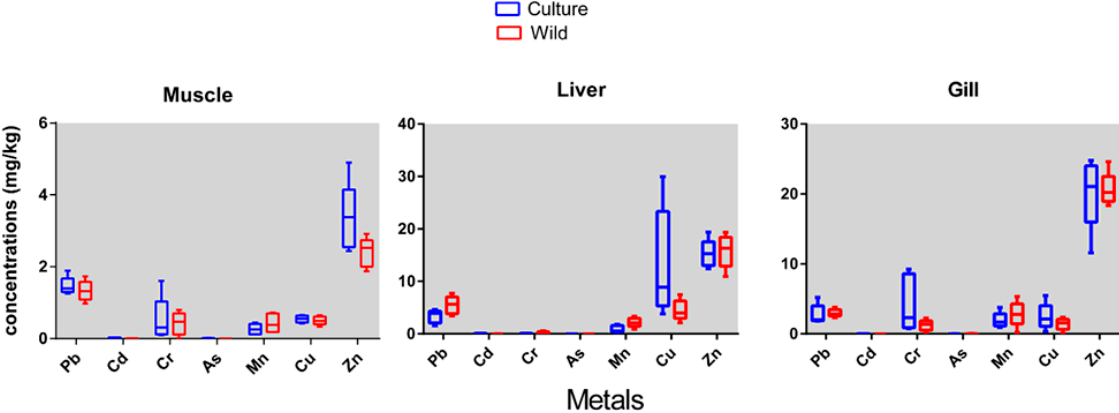
Figure 2. Concentration of metals in muscle, liver and gill tissue of cultured and wild Barramundi fish. However, when compared to the metal concentration in individual organs of wild and farmed Barramundi, the results were different from the overall concentrations. ANOVA confirmed that metal concentrations in liver of wild and farmed Barramundi did not vary significantly (F = 21.92, p < 0.05). Nevertheless, Wilcoxon tests showed that the individual metal (Pb, Mn, Cu and As) concentrations in liver varied significantly between wild and farmed sea bass (for Pb: W = 15, p = 0.04, for Mn: W = 15, p = 0.04, for Cu: W = 15, p = 0.04, for As W = 15, p = 0.04), and did not vary for Cd (W = 14, p = 0.07), Cr (W = 12, p = 0.22), or Zn (W = 15, p = 0.89). For gills, ANOVA demonstrated that metal concentrations in